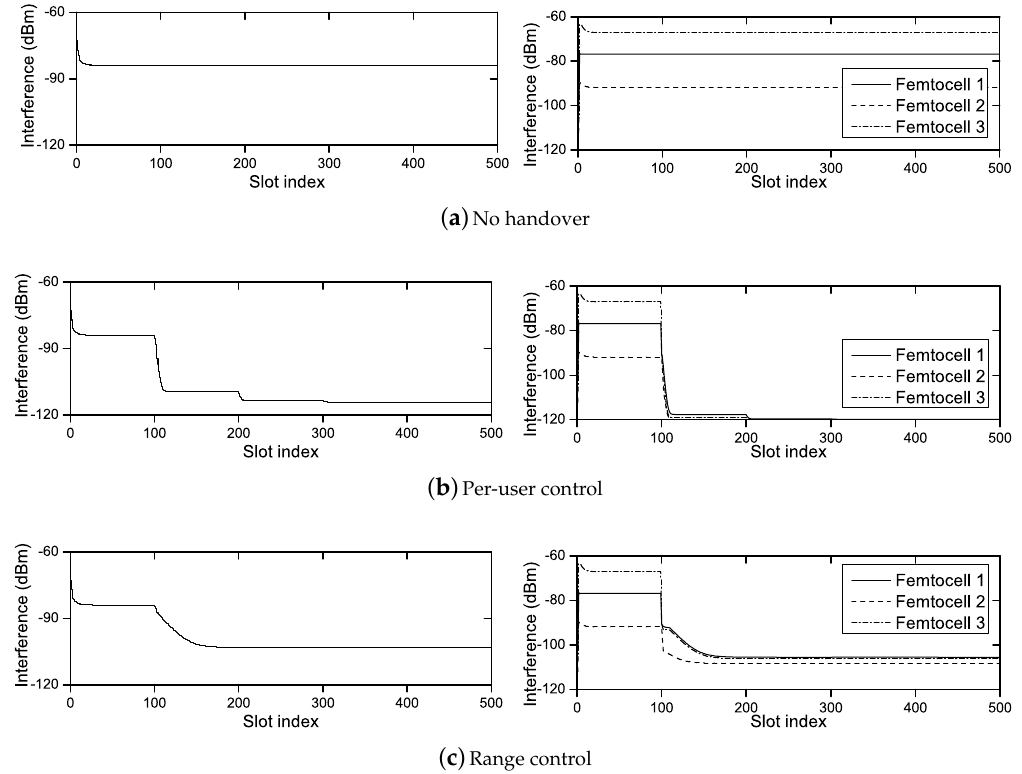
Figure 4. Time evolution of macrocell ( left ) and femtocell ( right ) uplink interference for different mechanisms.